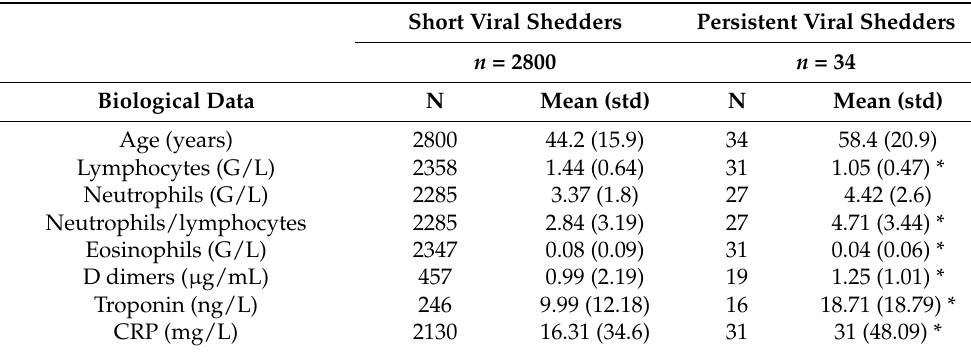
Table 2. Comparison of biological data for 2800 short shedders (nasopharyngeal